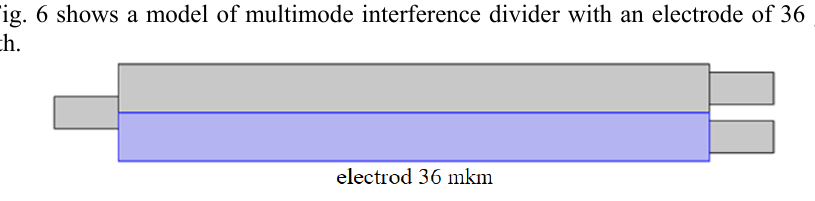
Fig. 6 . Model of multi mode interference divider with an electrode of 36 μm in length .